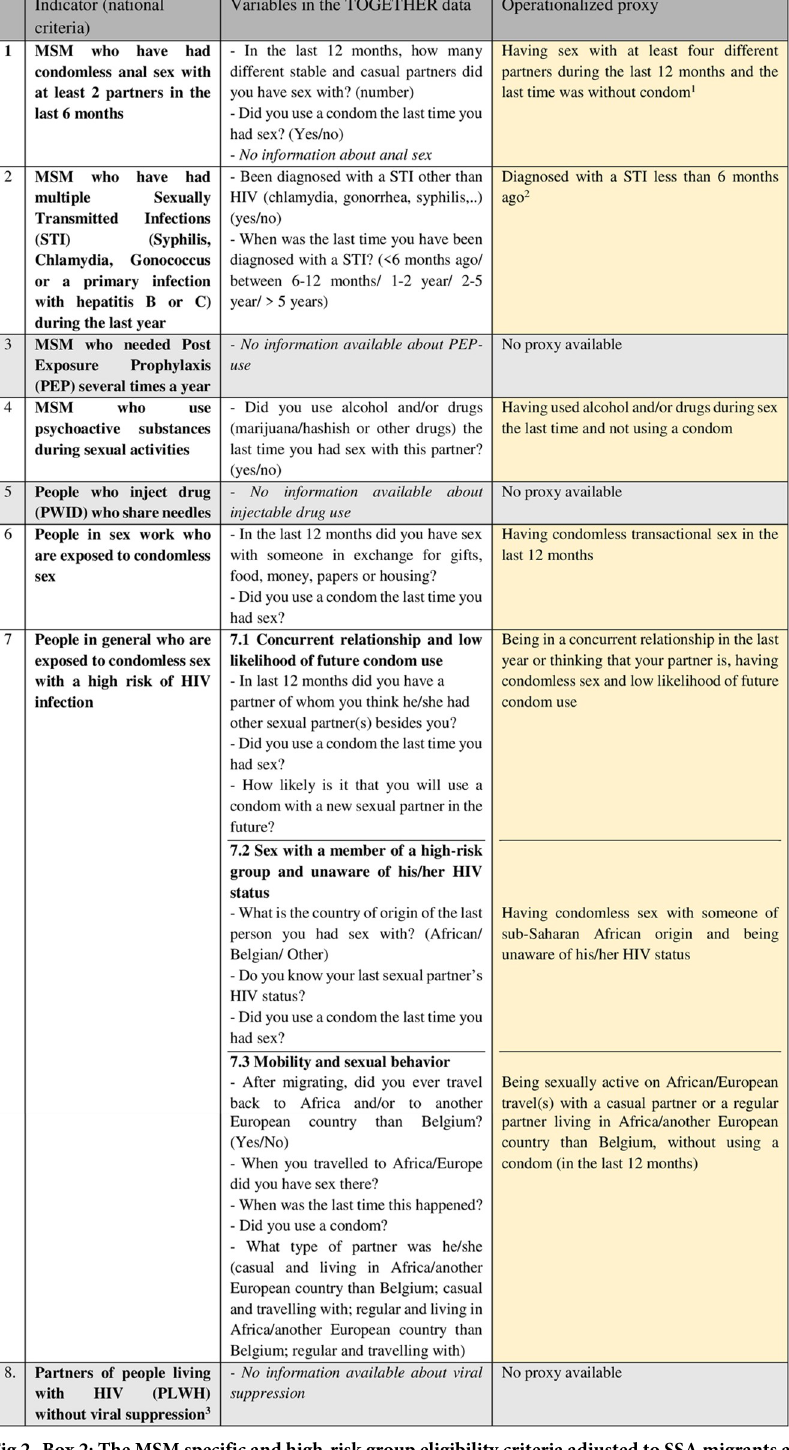
PLOS ONE | https://doi.org/10.1371/journal.pone.0256269 August 18, 2021 4 /